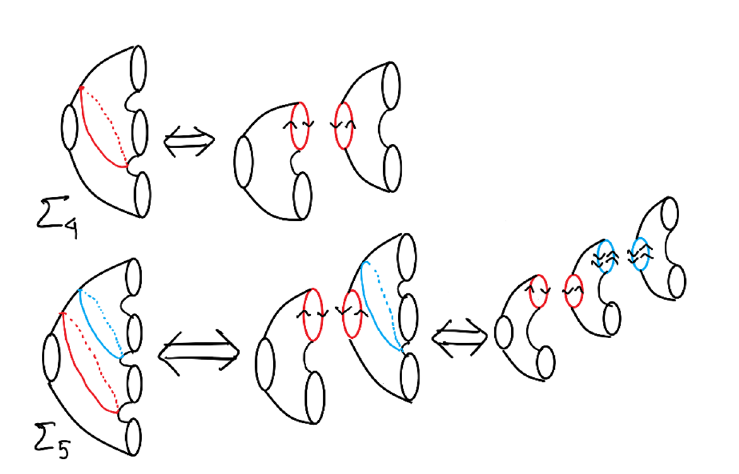
Figure 2. Describing higher number of boundaries.